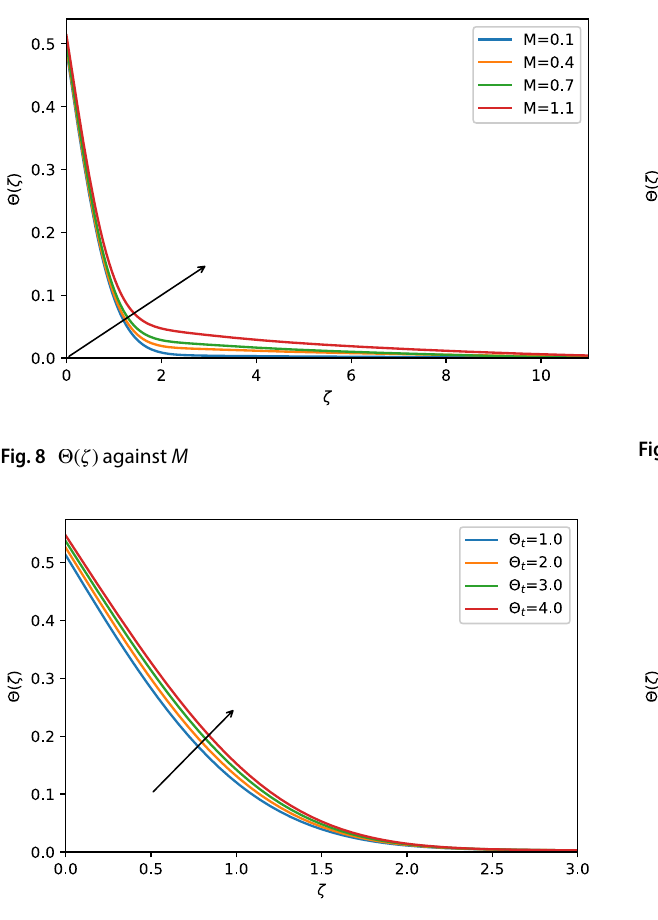
Fig. 11 Θ( 𝜁 ) against Bi